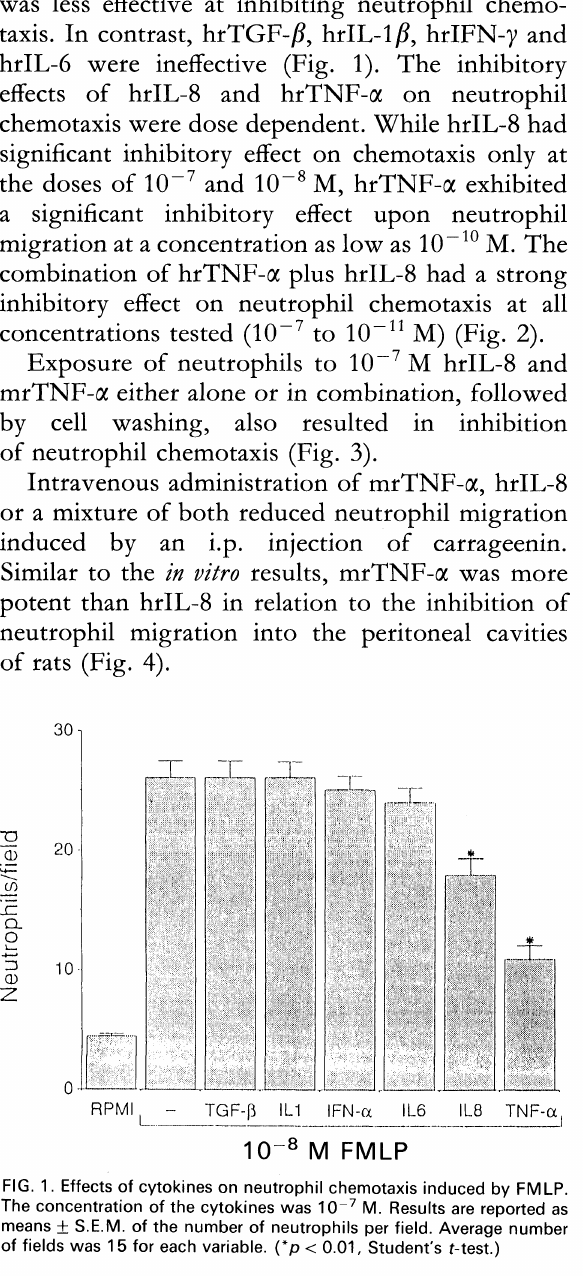
398 Mediators of Inflammation. Vol